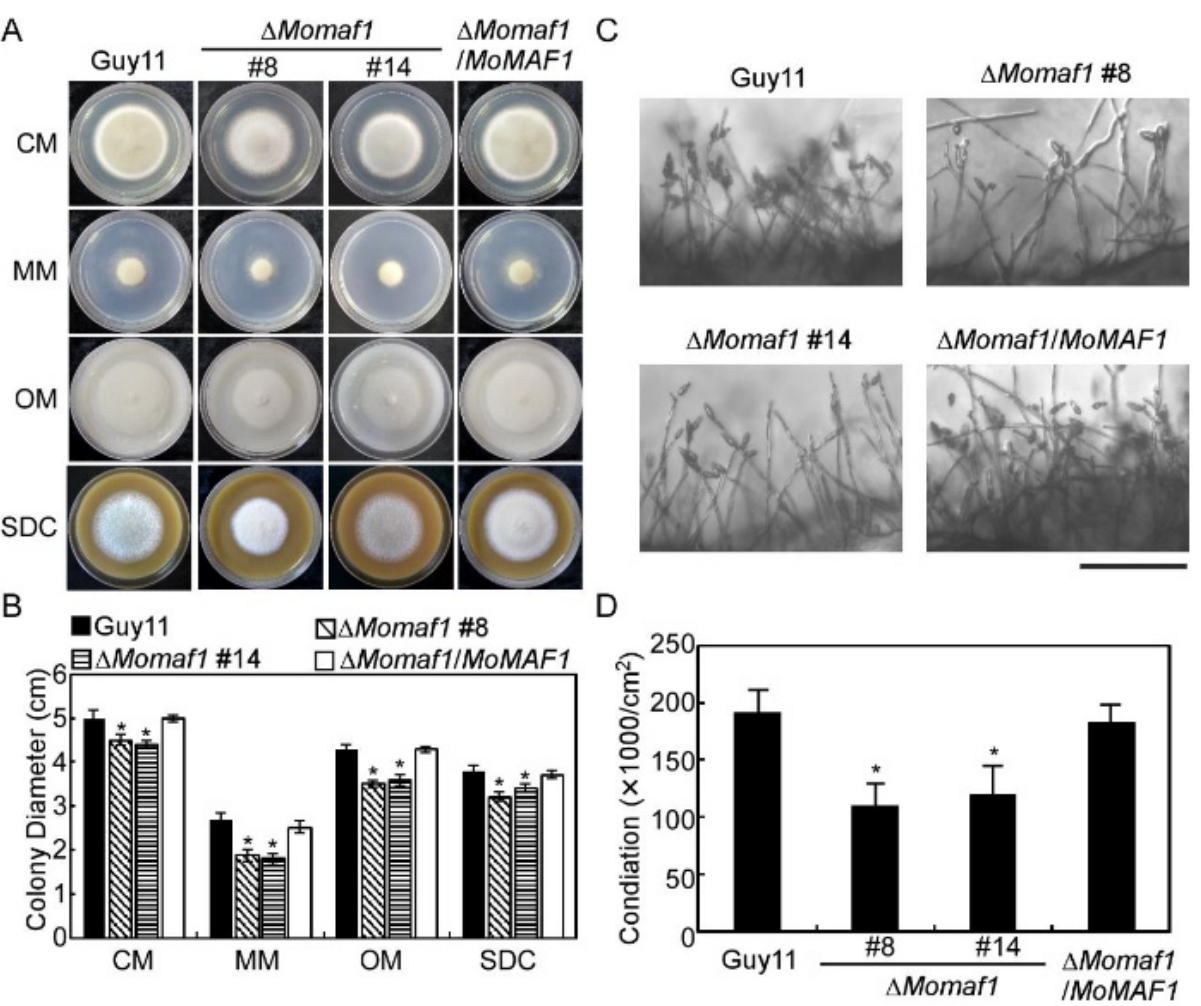
Figure 3. MoMaf1 is involved in vegetative growth and conidiation: ( A ) The Guy11, ∆ Momaf1 mutant, and ∆ Momaf1/MoMAF1 strains were inoculated on CM, MM, OM, and SDC medium; incubated at 28 ◦ C for 7 days; and photographed. ( B ) Statistical analysis of the colony diameter for the strains. Error bars represent ± SD (standard deviation), and asterisks denote statistical significance ( p < 0.01). ( C ) Conidia were observed and photographed under a light microscope after illumination for 24 h. Scale bar, 50 µ m. ( D ) Statistical analysis of the conidial number of the indicated strains. Error bars represent ± SD, and asterisks denote significant differences ( p < 0.01).